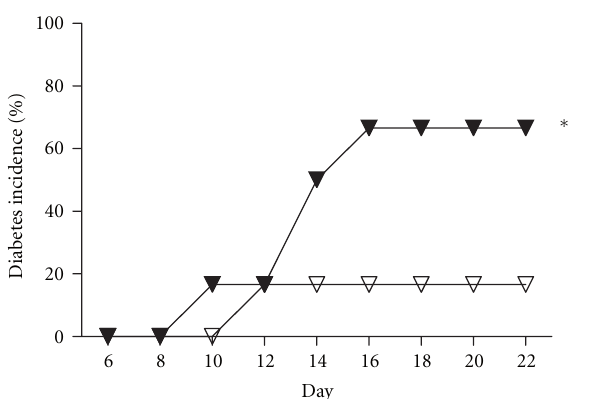
Figure 3: Normal glucose handling in CD73KO mice. Blood glucose levels following 1mg/g BW of intraperitoneal glucose. WT mice (black squares, n = 6); CD73KO mice (black triangles, n = 8); ns—not significant versus WT